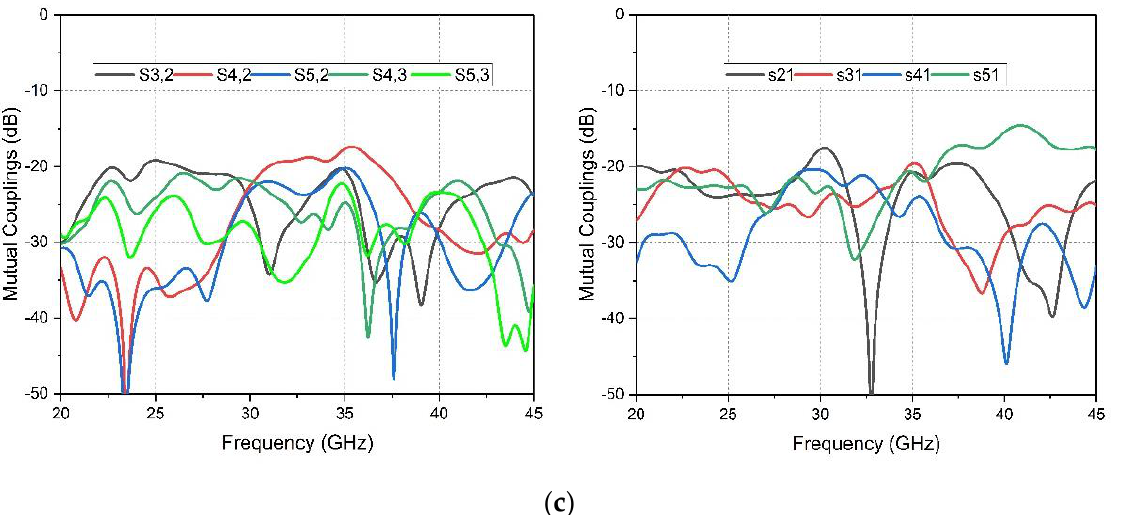
Figure 7. Reflection coefficients of Rotman lens designed on ( a ) microstrip line and ( b ) SICL technology and ( c ) mutual couplings between the input beam ports of the SICL.